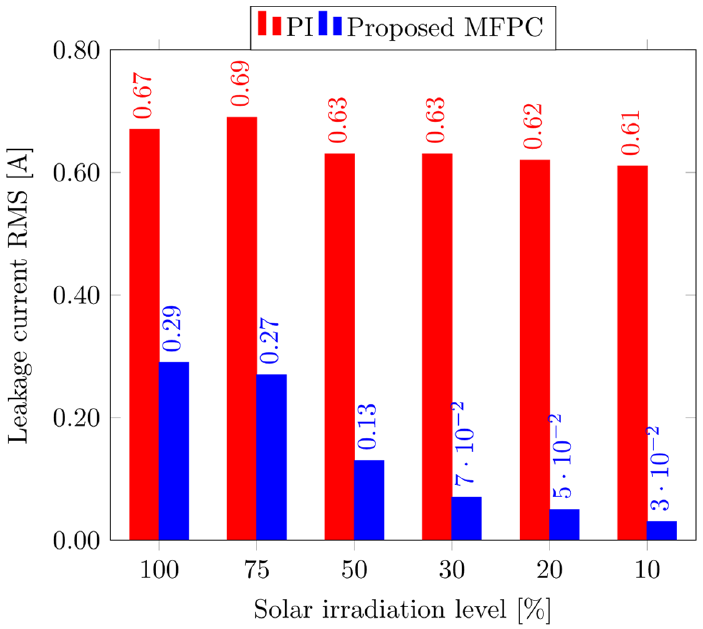
Figure 11. Relationship between the irradiation level and the RMS of the leakage current for both controllers.